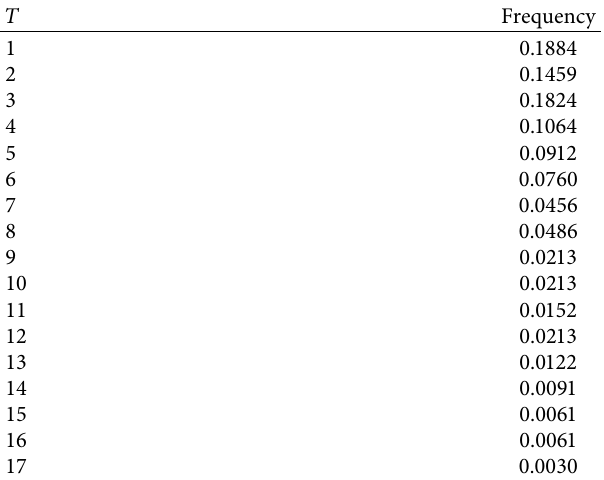
Figure 3: The empirical distribution of the positive serial time with 329 confirmed cases. The reference fitted distributions are Gamma distribution with mean 4.43 and variance 10.23 (the blue line) and the Weibull distribution with mean 4.45 and variance 10.31 (the red dash- dotted line). The inserted is the histogram of all serial times for 411 confirmed cases, containing nonpositive ones. Table 4: Empirical distribution law of the positive serial interval T